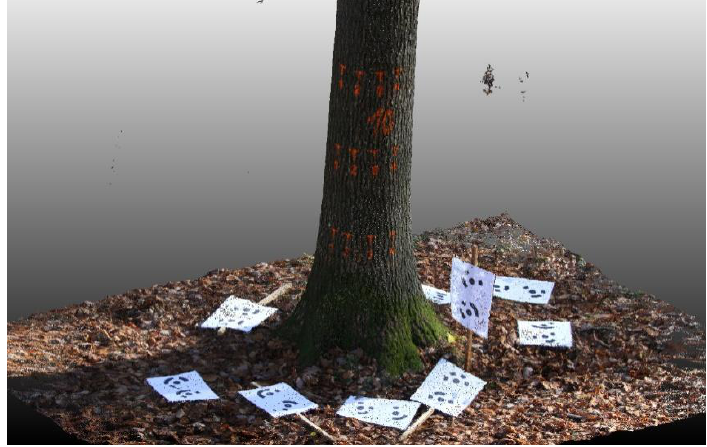
Figure 4. Scaling and orientation process using the coding markers.